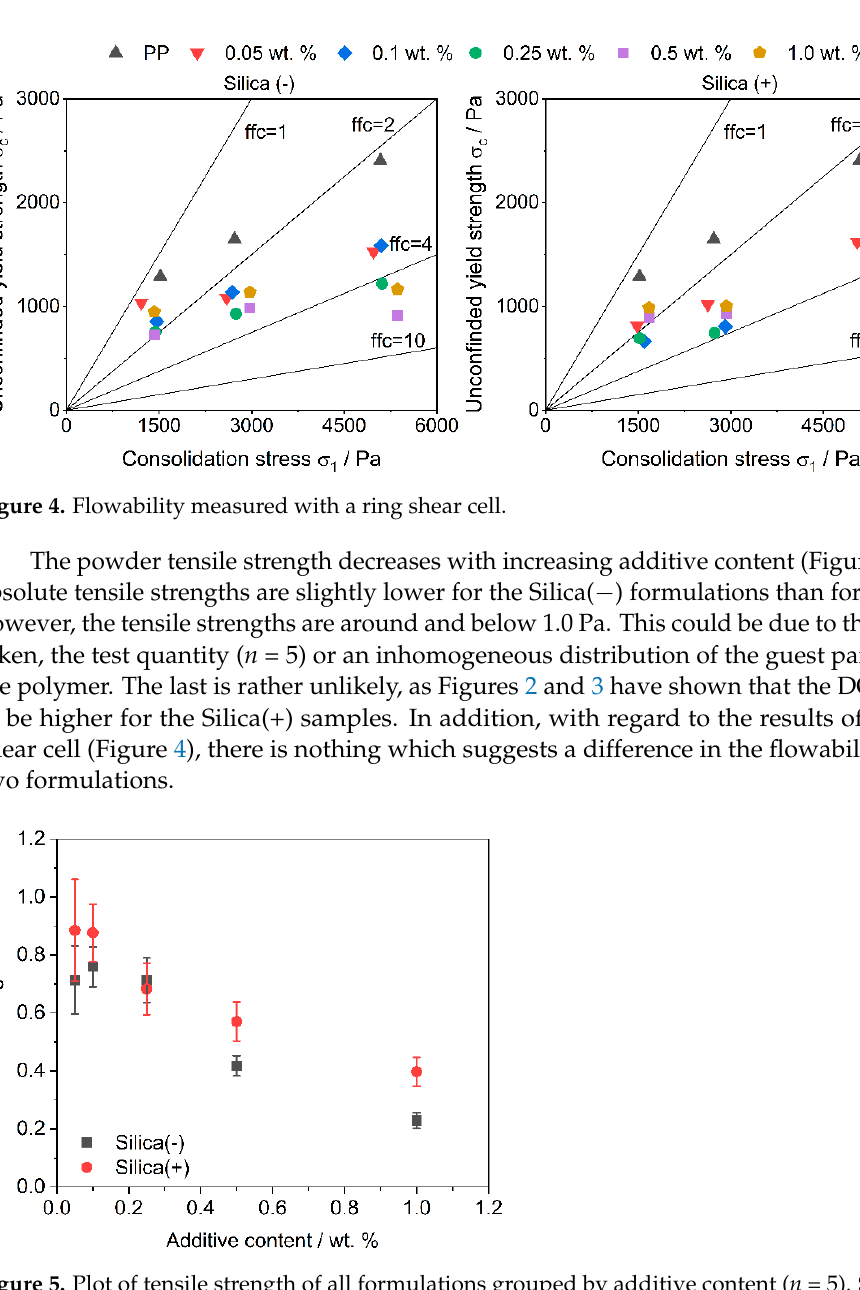
Figure 5. Plot of tensile strength of all formulations grouped by additive content ( n = 5). Silica(-) in black, Silica(+) in red; the tensile strength of unfunctionalized PP is 4.8 Pa ± 1.2 Pa.